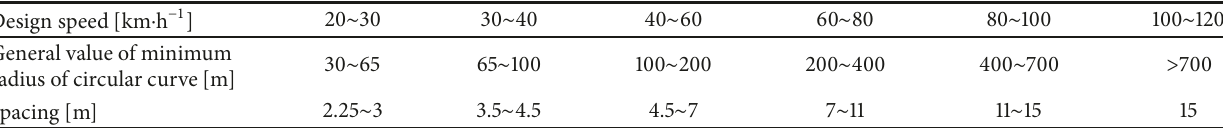
Table 1: Spacing for the radius of a circular curve.